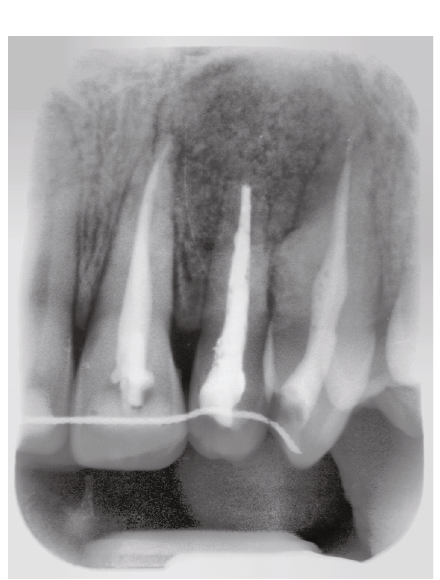
Figure 10: Final suture.